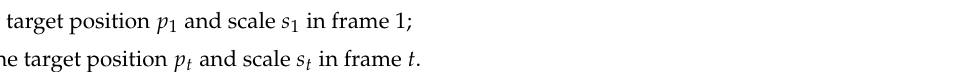
Table 1. Outline of the proposed tracking